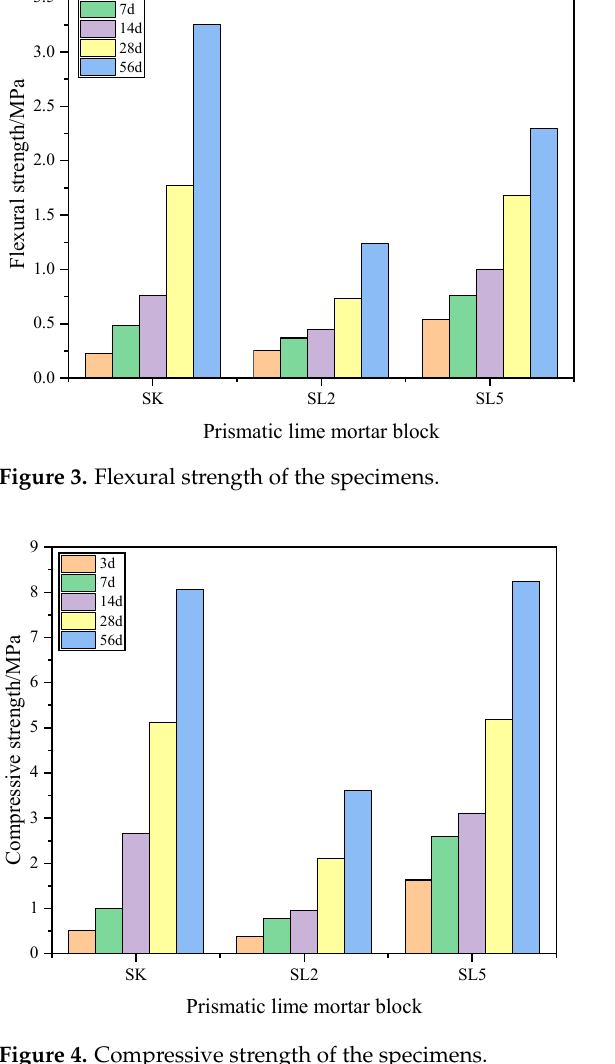
Figure 4. Compressive strength of the specimens.